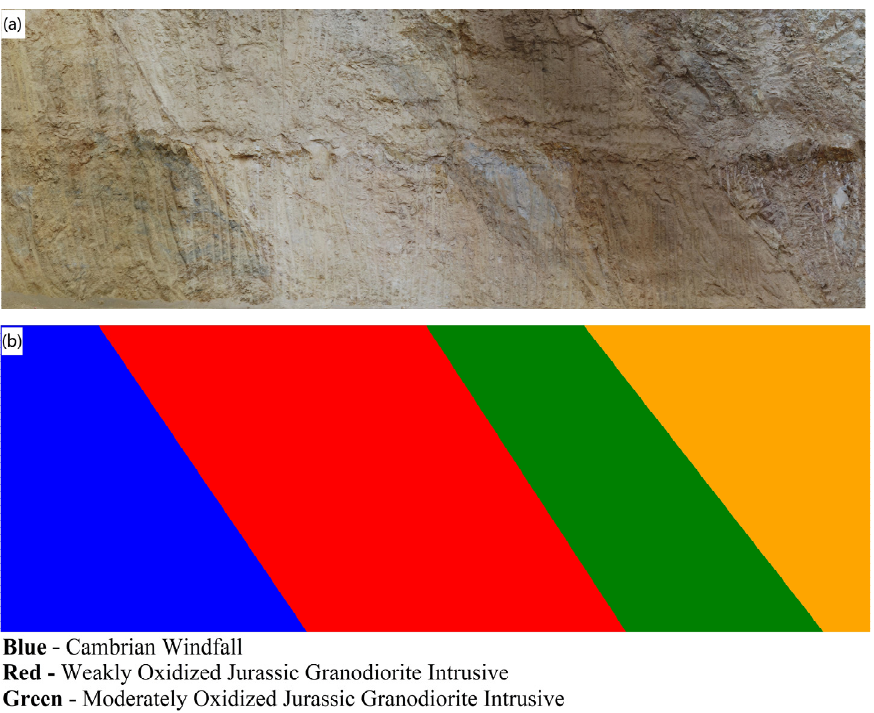
Figure 4. ( a ) The orthomosaic of the selected pit wall section for Top Pit (simple case). ( b ) The corresponding “novice-labelled” ground truth map.